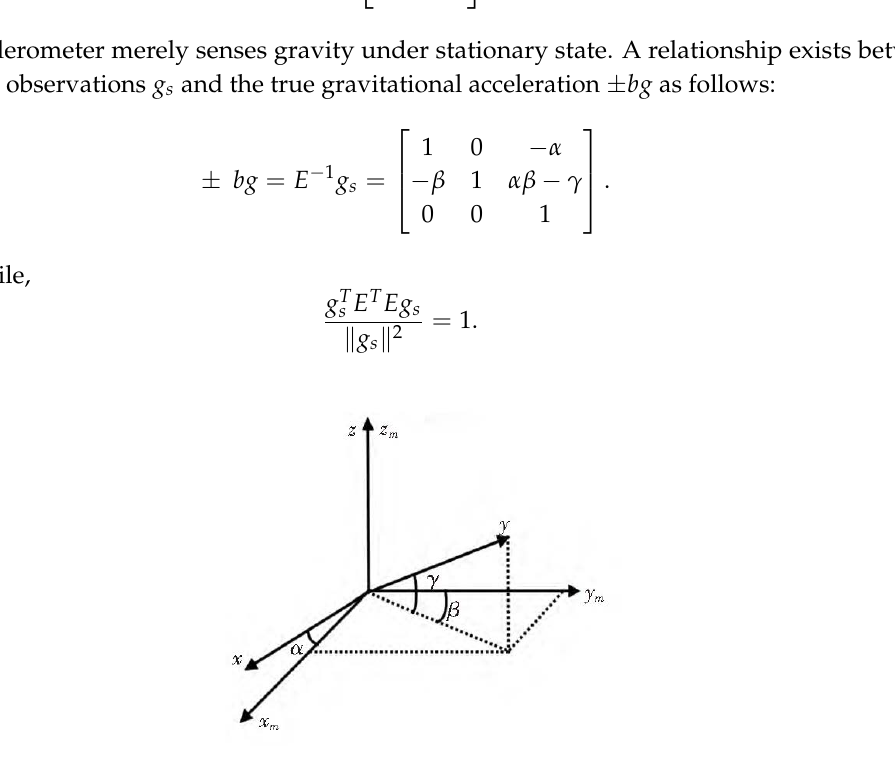
Figure 2. Non-orthogonal angle error of tri-axis